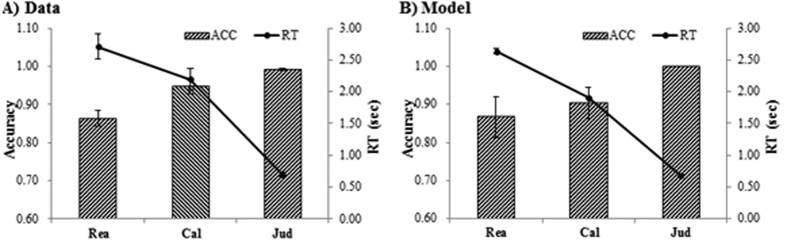
Behavioral performance for Rea, Cal, and Jud problems.(A) the data; (B) the model fits. Error bars represent the standard error.